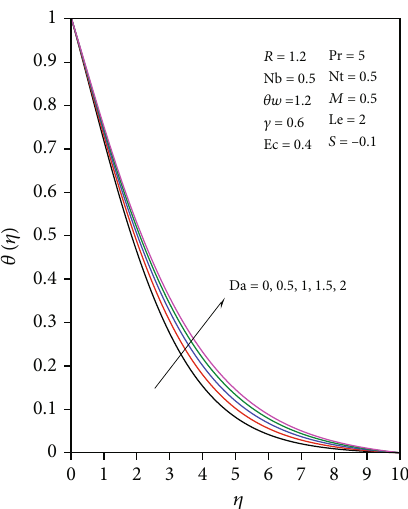
Figure 11: Temperature pro fi le for di ff erent values of Da .